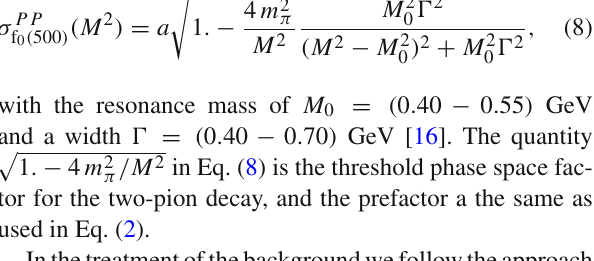
nance according to Eq. (8) is displayed by the dashed cyan line, with a central value for the mass M 0 as well as for the width (cid:7) , M 0 = 0 . 475 GeV and (cid:7) = 0 . 55 GeV, respec- tively. The contribution of the f 1 and f 2 trajectory are shown by the solid green and by the dashed blue line,